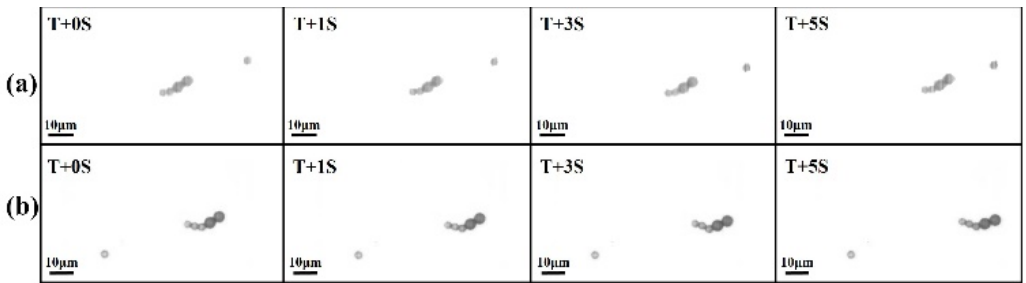
Figure 11. Sequential images of the ( a ) L2S2 and ( b ) L2S3 swimmers in an oscillating field with a strength of H p = 1500 A/m and H d = 1900 A/m and a frequency of f = 10 Hz. T represents the time when the swimmer started swimming at the greatest velocity and then cruised at a nearly constant speed, while S refers to second.